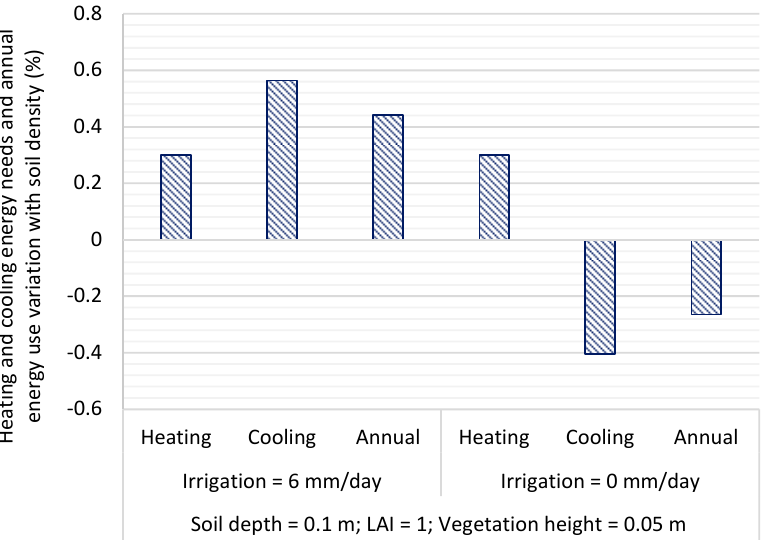
Figure 9. Impact of soil density variation on heating and cooling energy needs and annual energy use for irrigation of 6 mm/day and 0 mm/day.